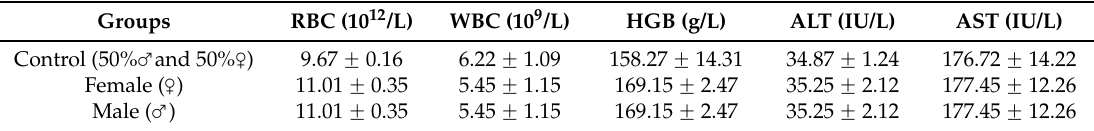
Table 3. Effect of GBP on haematological indexes in